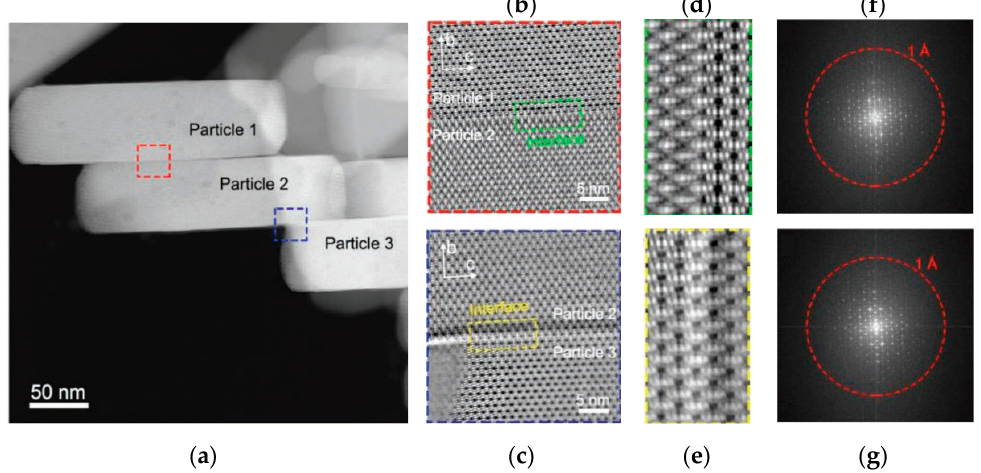
Figure 11. ( a ) The HAADF-STEM image of assembled ZSM-5 particles; ( b , c ) The iDPC-STEM images of the (010) interfaces in the areas marked in ( a ); ( d , e ) The zoom-in interface areas of iDPC-STEM images marked in ( b , c ); ( f , g ) The FFT patterns corresponding to ( b ) and ( c ), respectively. Reprinted/adapted with permission from Ref. [94]. Copyright 2019, Advanced Materials.